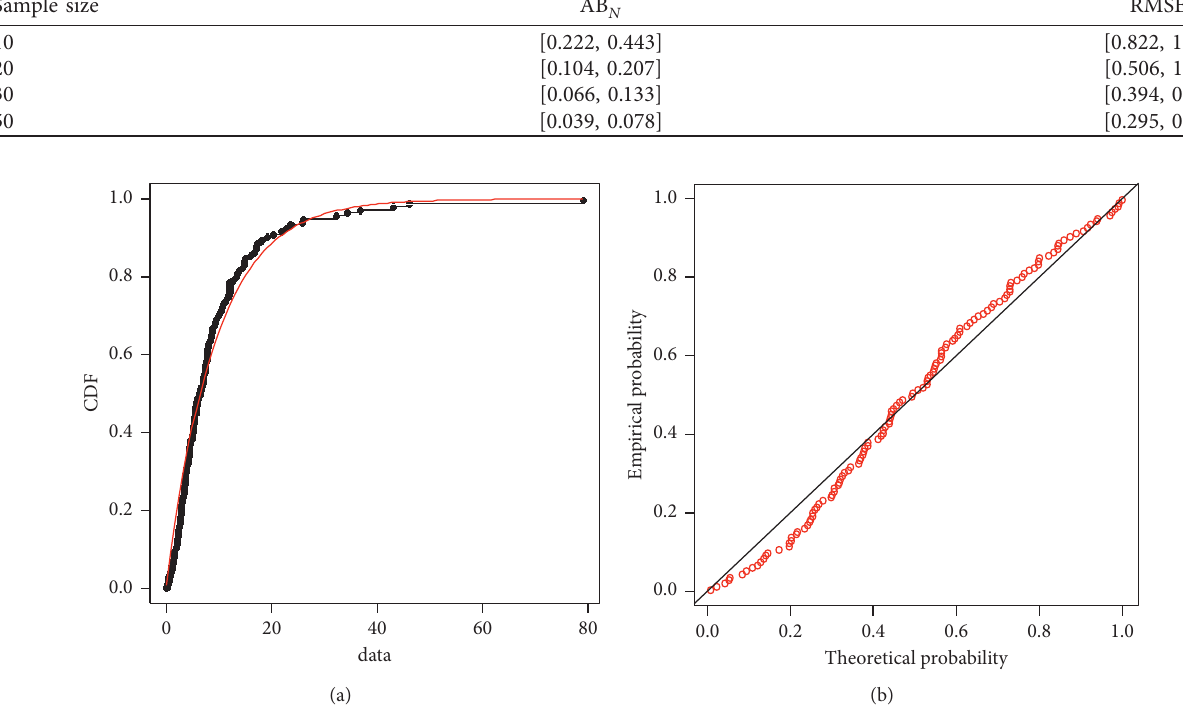
Figure 3: Graphical overview of the remission time dataset: (a) CDF-plot and (b) PP-plot. Table 3: Remission periods of 128 cancer patients.